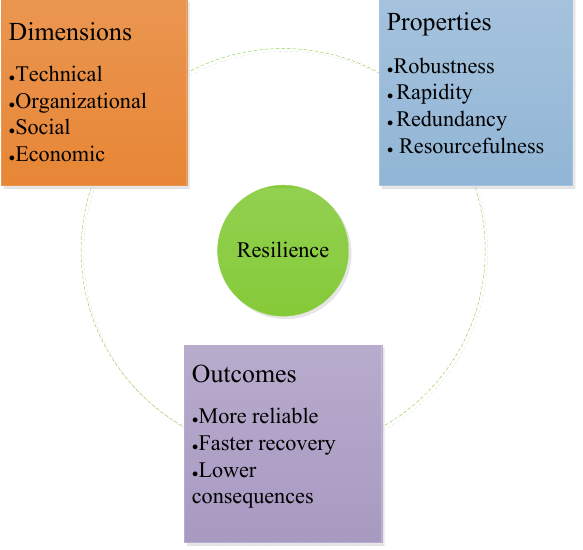
Figure 4. Assessment framework of resilience (11 aspects).